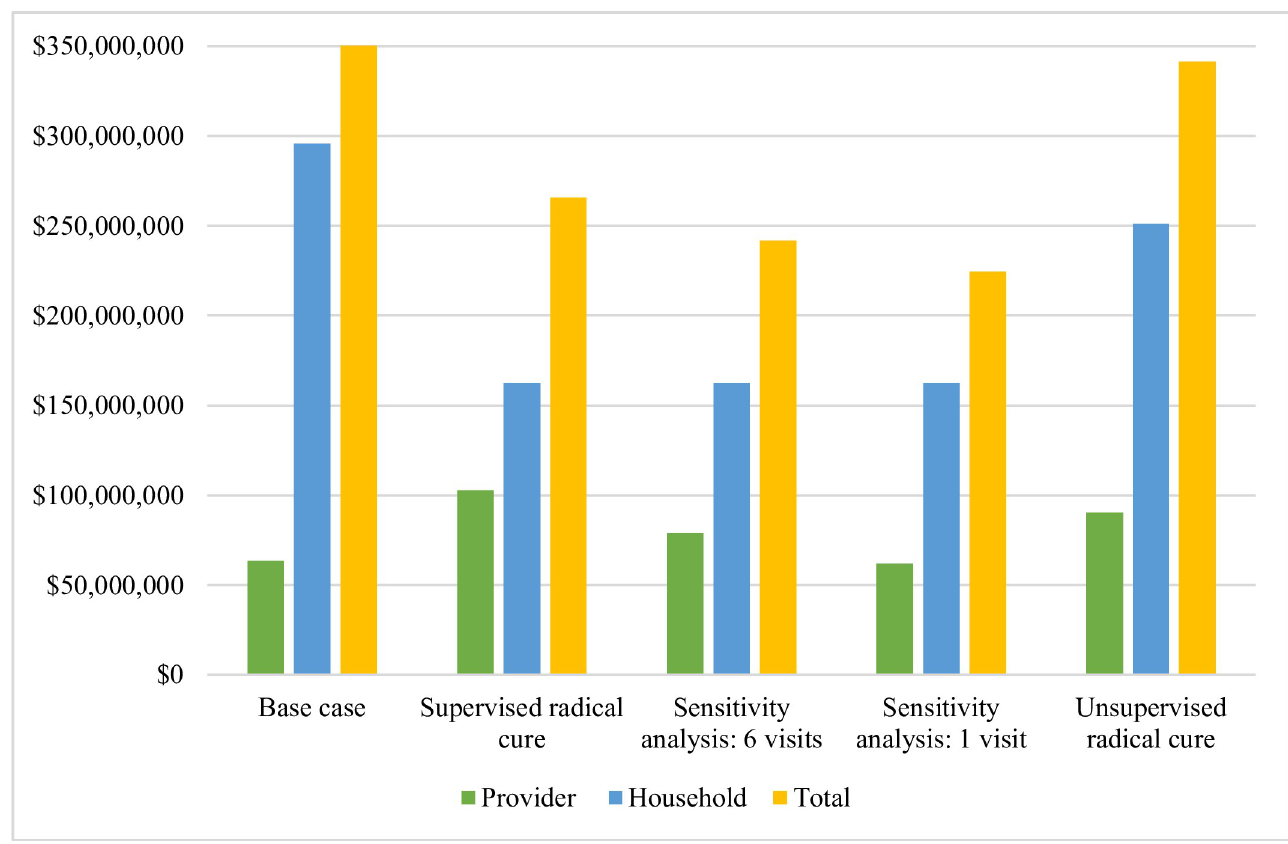
Fig 3. Comparison of provider, household, and total cost comparison of the baseline global costs and the Supervised radical cure and Unsupervised radical cure scenarios. Sensitivity analyses for the Supervised radical cure scenario included 6 visits and 1 visit of supervision as compared to 13 visits. Costs are in 2017 United States Dollars.